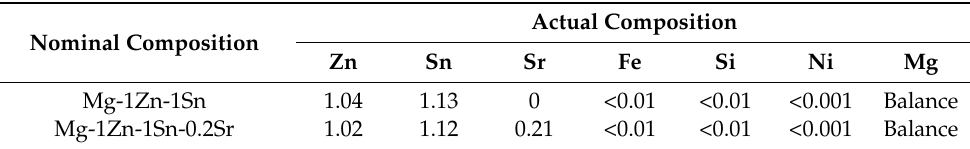
Table 1. Actual composition of the Mg-1Zn-1Sn and Mg-1Zn-1Sn-0.2Sr alloys (wt.%).